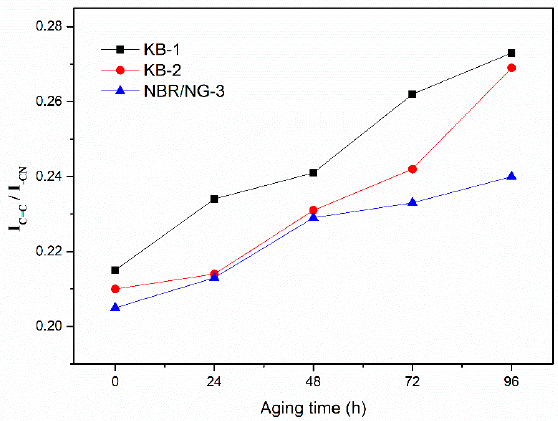
Figure 16. Relative content changes of –CH in KB-1, KB-2, and NBR/NG-3 at different aging times.